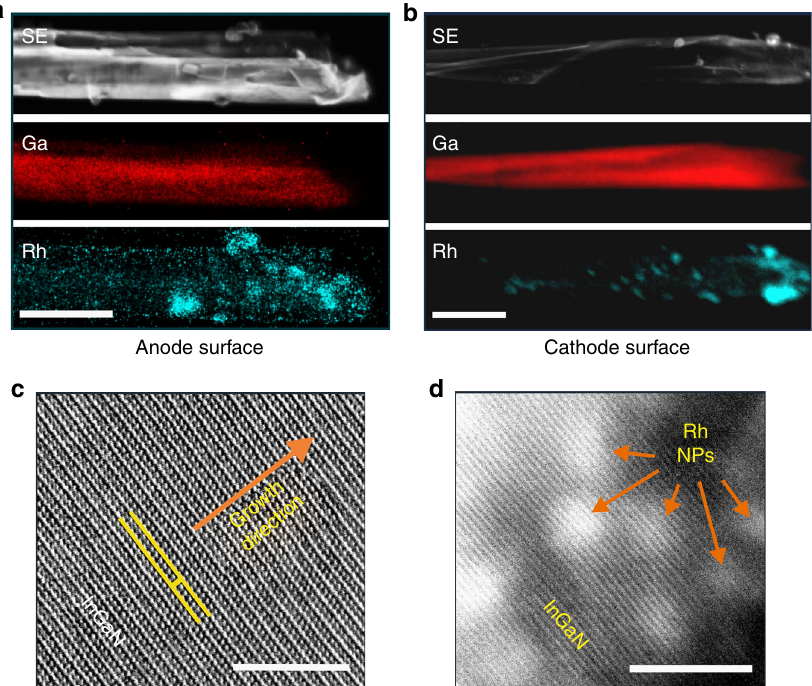
Fig. 2 Surface selectivity of InGaN photochemical diode for Rh-nanoparticle deposition. Comparison of STEM-SE and EDXS elemental mapping on two different surfaces of InGaN nanosheet (decorated with Rh-nanoparticles) shows that a very few Rh nanoparticles were deposited on the anode (outer) surface, whereas b signi fi cantly large number of Rh-nanoparticles get deposited on the cathode (inner) surface. Scale bars, 400 nm. HRSTEM-BF lattice fringe image from InGaN photochemical diode nanosheet, illustrating c defect-free single crystalline In 0.22 Ga 0.78 N anode surface, and d Rh nanoparticles on the crystalline cathode surface of photochemical diode. Scale bars, 5 nm. A radial density fi lter was used for Fig.